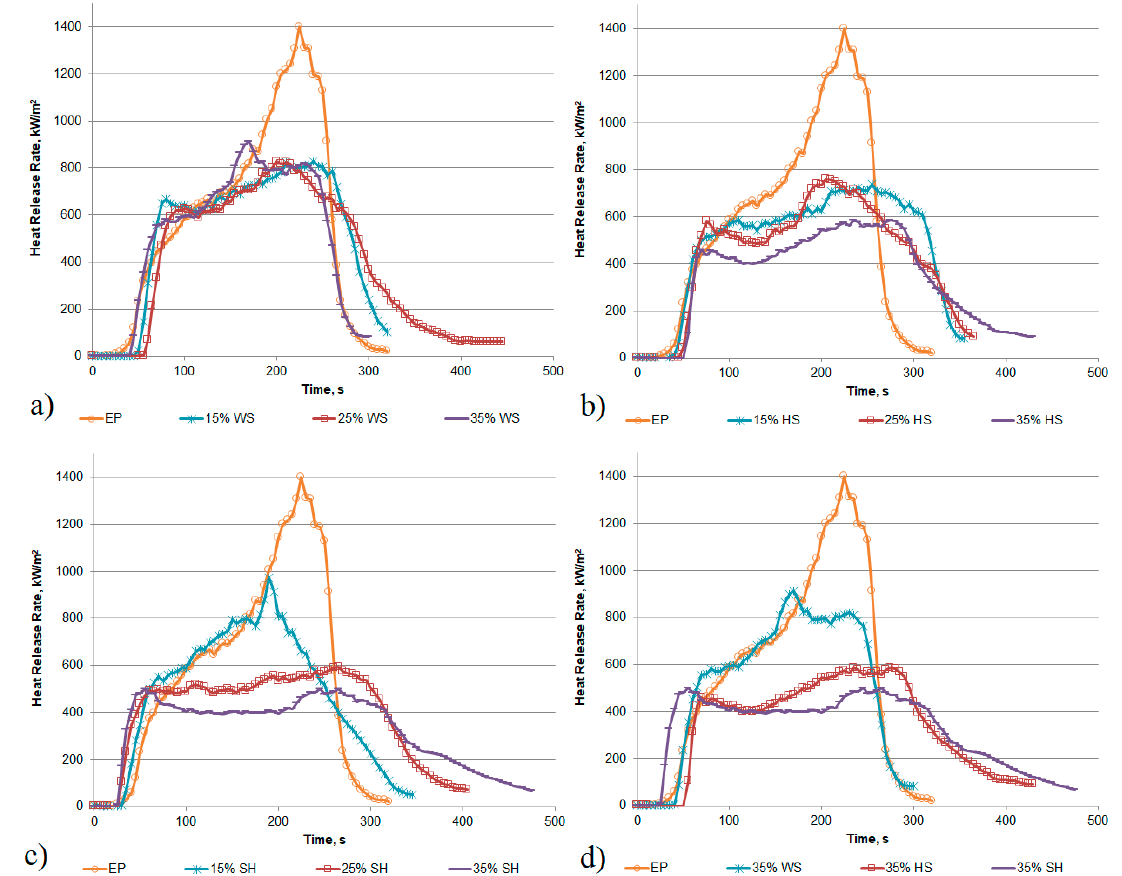
Figure 8. E ff ects of plant waste filler on the heat release behaviour of epoxy resin composites: ( a ) 15–35% WS; ( b ) 15–35% HS; ( c ) 15–35% SH; ( d ) 35% WS, HS and